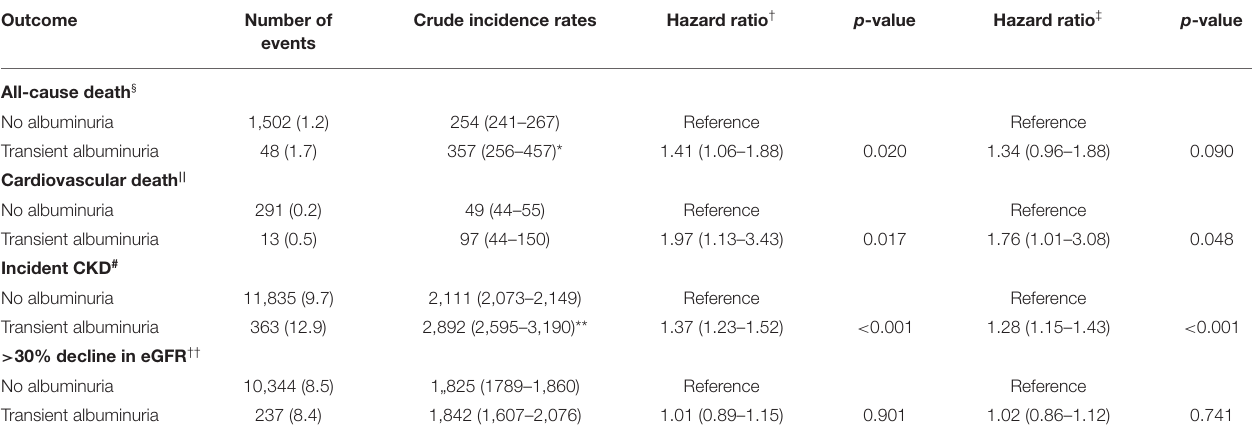
TABLE 2 | Relative hazard ratio of outcome in the transient albuminuria group compared to that in the no albuminuria group. Outcome Number of Crude incidence rates Hazard ratio † p -value Hazard ratio ‡ p -value events